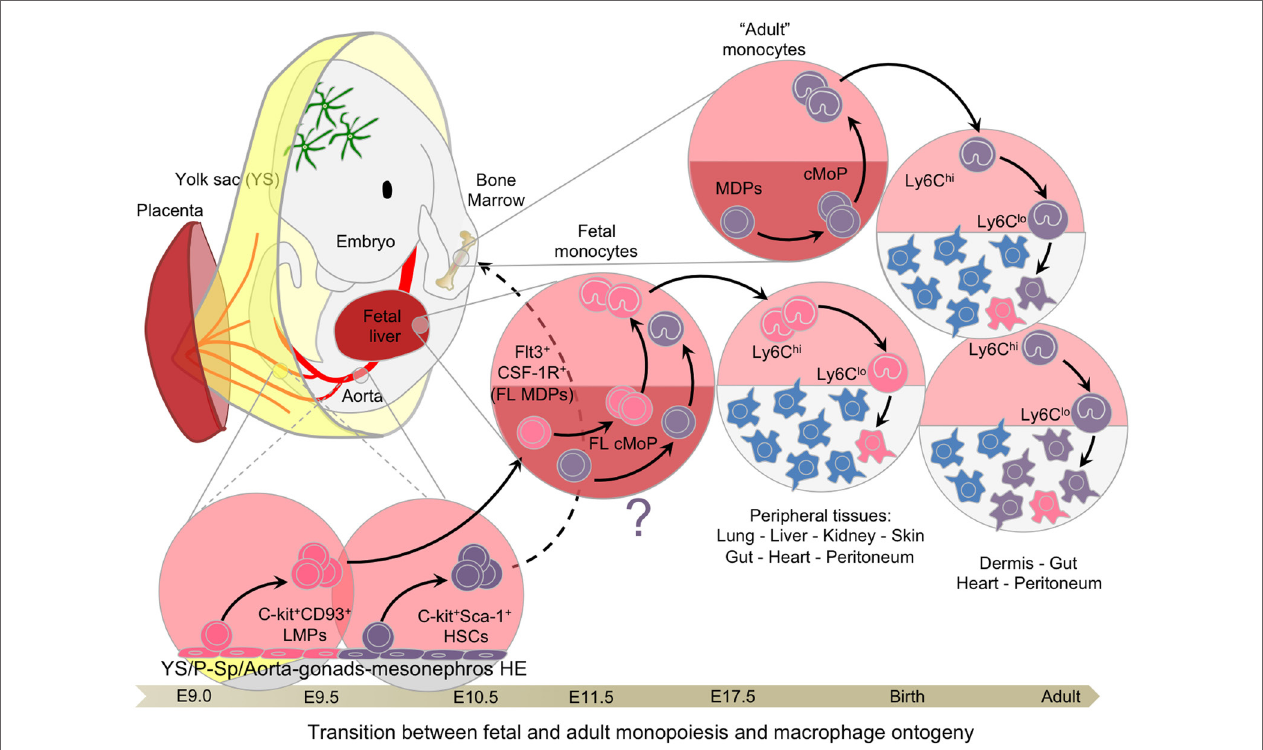
FiGURe 4 | Transition between fetal and adult hematopoiesis . Hemogenic endothelial cells from extra and intra-embryonic hematopoietic tissues generate C-Myb-dependent multipotential progenitors, such as LMPs and pre-HSCs, between E9.0 and E10.5, culminating with the emergence of mature HSCs with long-term reconstitution-bearing potential. CD93 (AA4.1) expression is associated with the emergence of lymphoid potential, whereas Sca-1 is the hallmark of HSCs. These progenitors seed the fetal liver around E10/E11, expanding and giving rise to the various lineages of the hematopoietic system, including fetal monocytes. These late fetal monocytes continue to participate in the tissue-resident macrophage network until hematopoiesis switches completely from the fetal liver to the bone marrow. Once adult hematopoiesis begins to take place in the bone marrow generating monocytes, certain tissues, such as the dermis, heart peritoneum, and the gut, continue to recruit adult monocytes to generate resident macrophages and replace with time the embryonic-derived